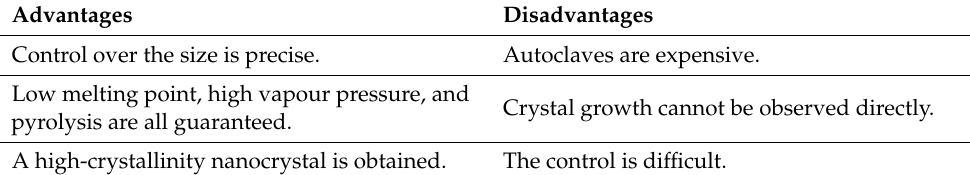
Figure 7. The hydrothermal-synthesis technique. Table 5. Advantages and disadvantages of hydrothermal techniques.